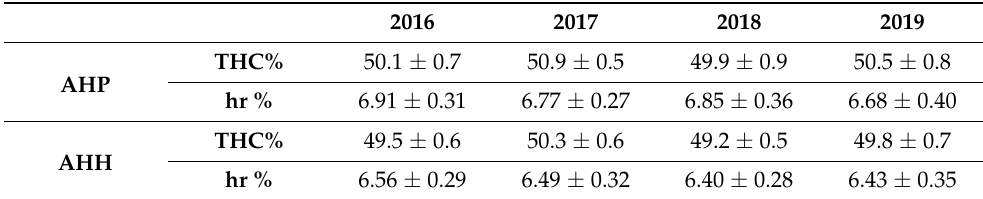
Table 3. Total humidity content *, THC% (for the fresh seeds, data obtained at 105 ◦ C), and residual humidity *, hr% (residual moisture at 101 ◦ C) in horse chestnut flour from AHP and AHH seeds, harvested in different